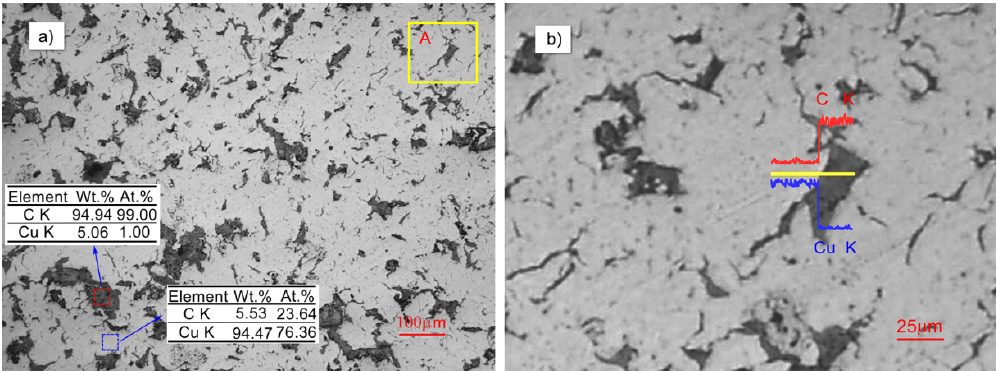
Figure 2. The scanning electron microscope (SEM) microstructure and EDS of Cu–C composite materials: ( a ) the SEM of copper graphite composite, ( b ) the line scan diagram of region A in ( a ).